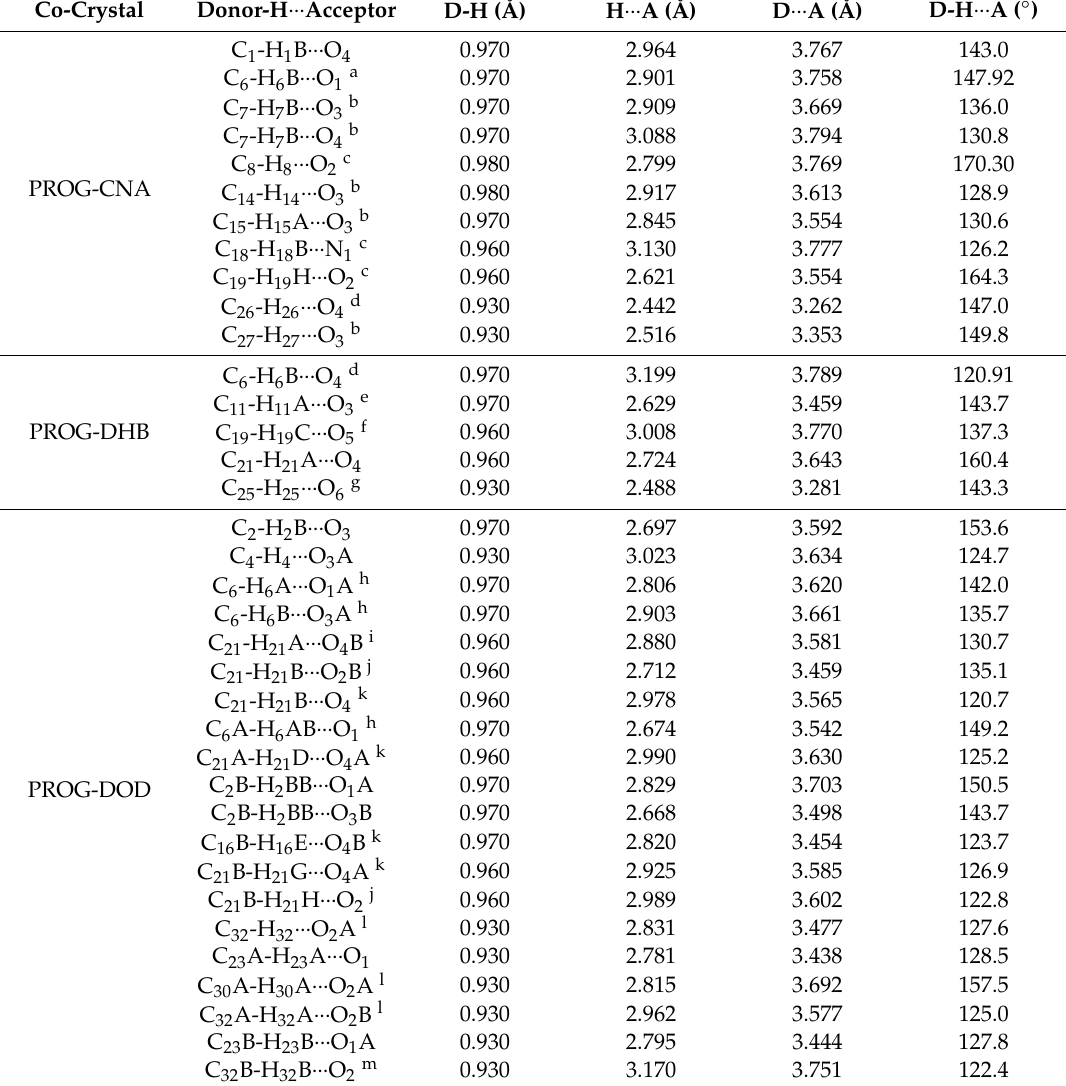
Table 2. C-H ··· O / N interactions in PROG-CNA, PROG-DHB, and PROG-DOD.